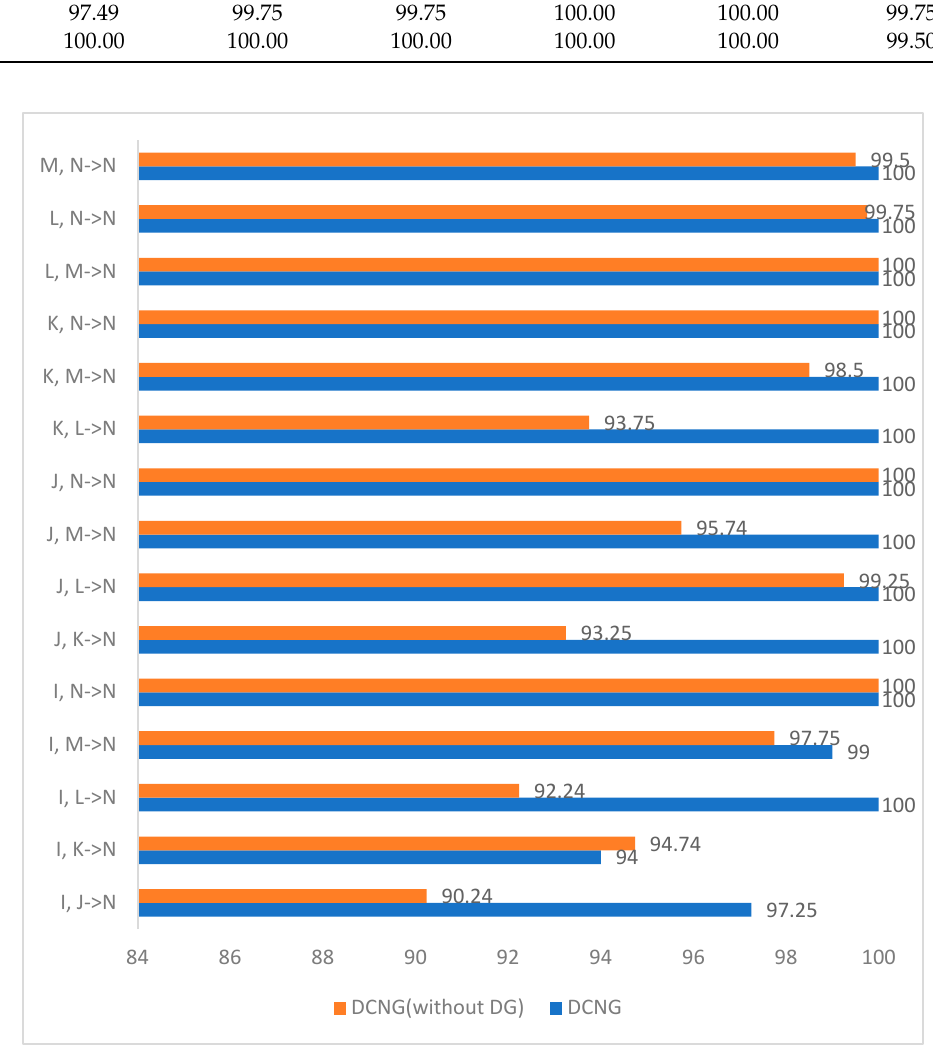
Figure 13. DCNG and ungeneralized model performance on 15 tasks in the MFPT dataset.